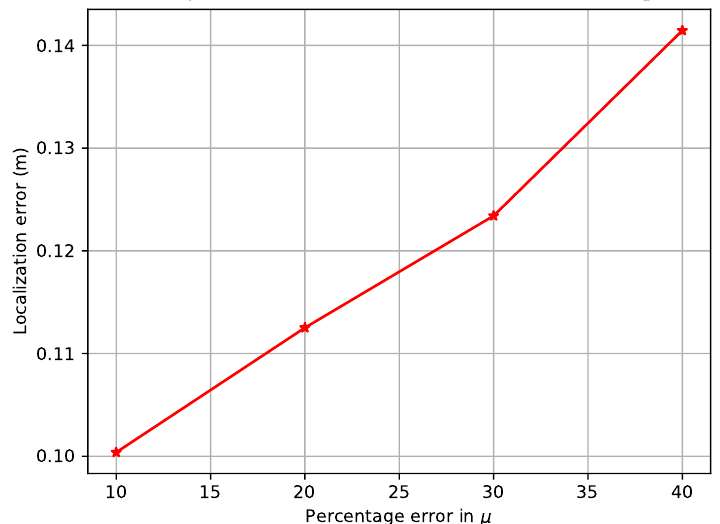
Figure 7. Sensitivity of time of arrival-based localization with respect to (cid:101) (cid:48)(cid:48) s .